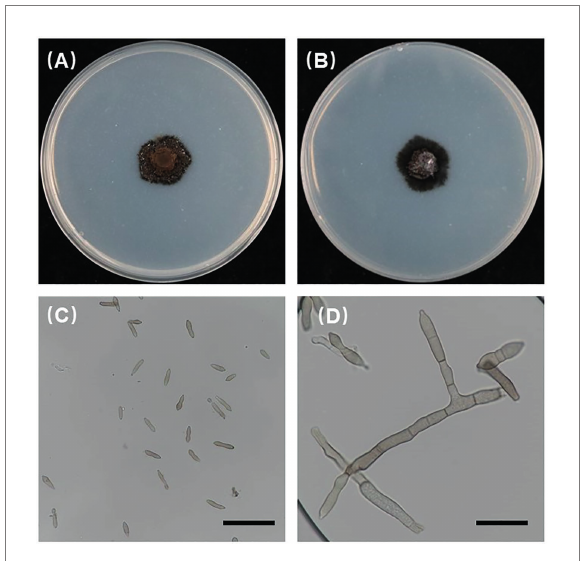
FIGURE 3 Morphological characteristics of Venturia carpophila. (A,B) Front and back view of 42-day-old PDA culture (petri dish is 90 mm); (C,D) conidia and conidiophores produced on PDA. Scale bars: C = 40 μ m; D = 20 μ